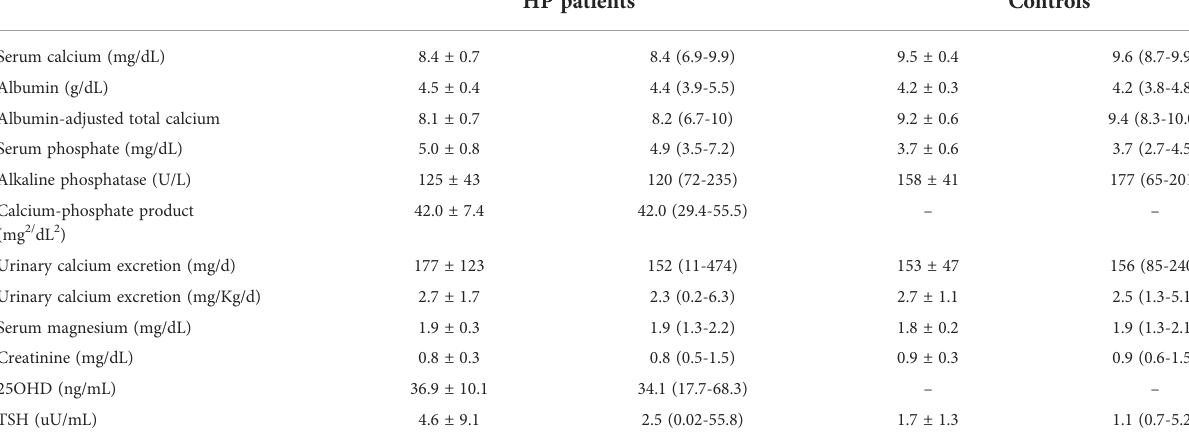
TABLE 1 Biochemical evaluation of the patients with postsurgical hypoparathyroidism on standard treatment with calcium and calcitriol and